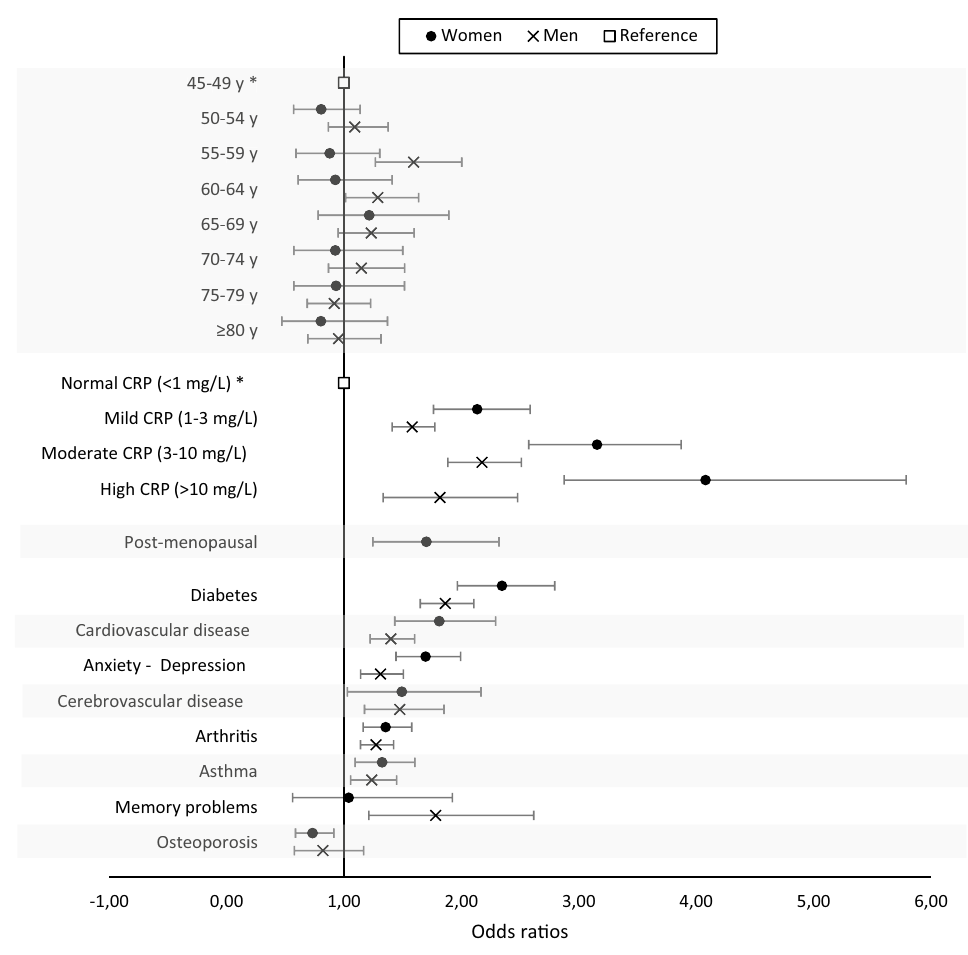
Figure 4. Adjusted odds ratios for high-risk for OSA in women (black circles) and men (grey x-marks) of age, level of systemic inflammation, OSA-related comorbidities and menopausal status with a statistically significant association with risk for OSA. White squares represent the reference categories. Bars represent the 95% confidence intervals. Hypothyroidism, chronic obstructive pulmonary disease, dementia, and Parkinson’s disease were included in the models but are not shown since they were not associated with high-risk for